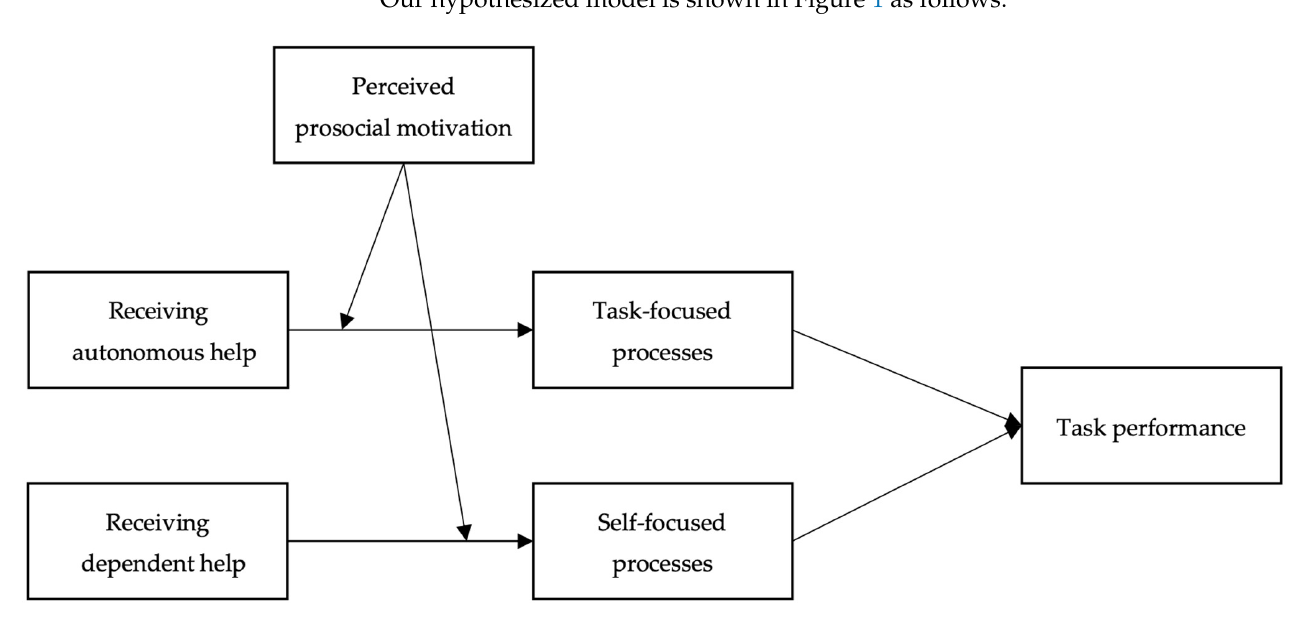
Figure 1. Theoretical Model.